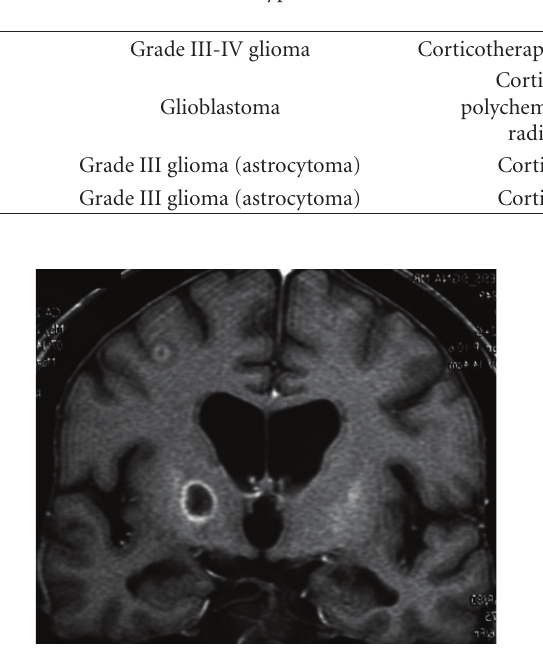
Figure 1: T1-weighted contrast-enhanced coronal MRI. Hypoint- ense nodular lesion in the right capsulothalamic area, with periph- eral annular enhancement. Small cortical-subcortical ipsilateral satellite lesion with annular enhancement and perilesional